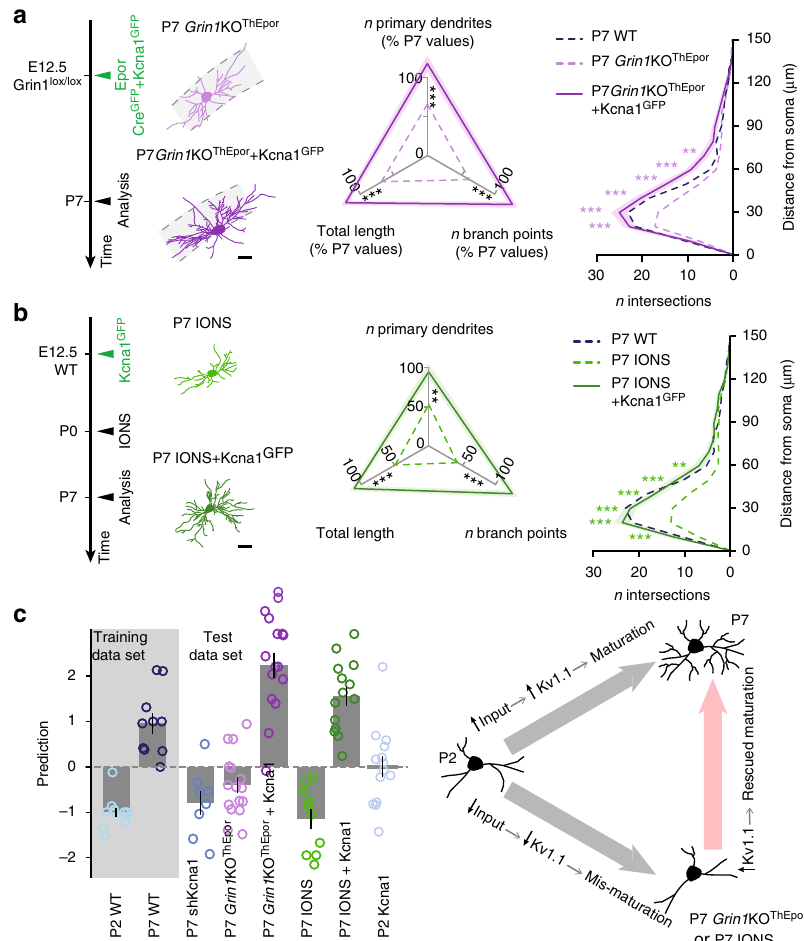
Fig. 5 Overexpression of Kv1.1 enables normal dendritic development of Grin1 KO ThEpor and VPM IONS neurons. a Kcna1 electroporation enables dendritic development in Grin1 KO ThEpor neurons (P7 Grin1 KO ThEpor + Kcna1 GFP n = 15 from 6 mice). P7 WT and P7 Grin1 KO ThEpor data reported from Fig. 1b and d. Scale bar: 20 μ m. b Kcna1 overexpression enables the dendritic development of VPM IONS neurons (P7 IONS + Kcna1 GFP n = 14 from 7 mice). P7 WT and P7 IONS data reported from Figs. 1b and 4c. Scale bar: 20 μ m. c Left: linear model integrating the dendritic complexity parameters described above, using control P2 and P7 conditions as training data sets. Right: summary of the fi ndings. One-way ANOVA with Tukey's post-hoc test for all statistical tests relating to dendritic complexity, except for Sholl analyses for which a two-way ANOVA with Tukey's post-hoc test was used. * P < 0.05, ** P < 0.01, *** P <